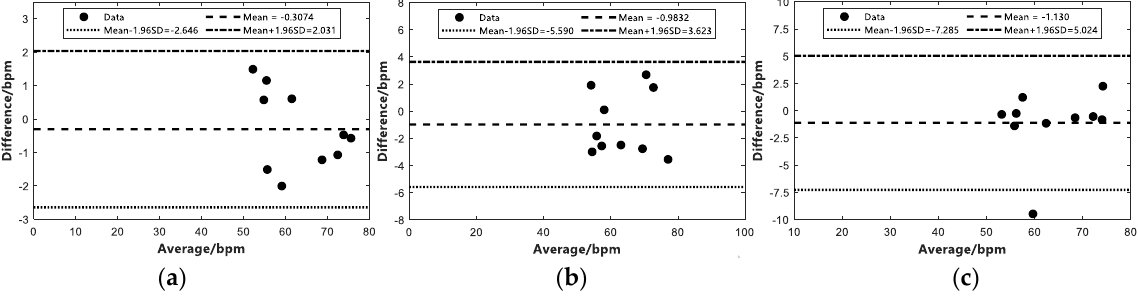
Figure 12. Bland – Altman consistency analysis of heartbeat measured by IR − UWB radar and ECG under different number of targets. ( a ) One subject. ( b ) Two subjects. ( c ) Three subjects.